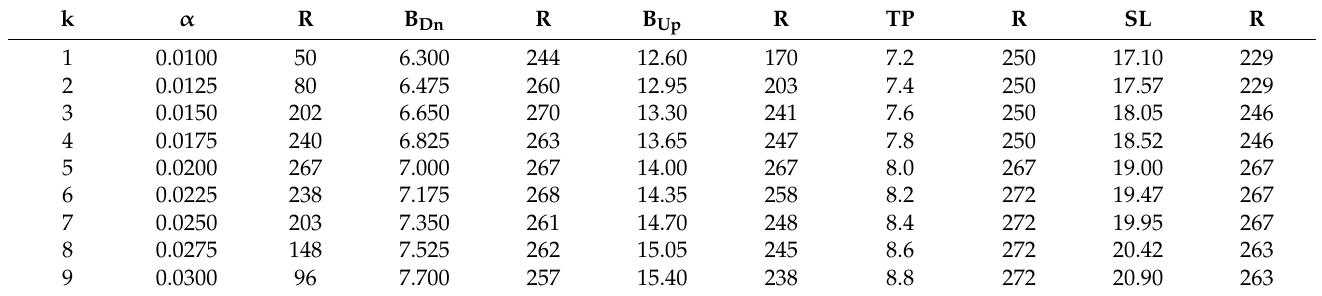
Table 1. Effectiveness of the management strategy with varying parameters.